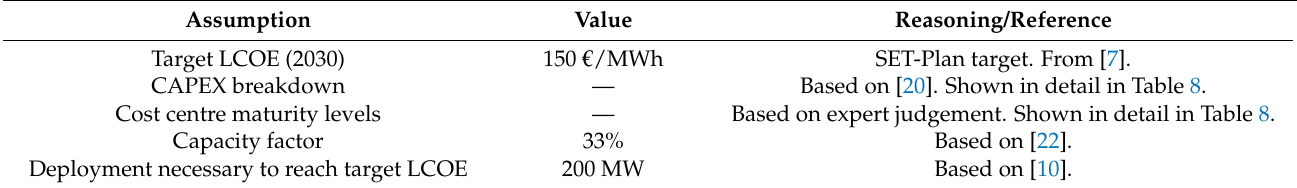
Table 7. Technology specific assumptions used in wave case